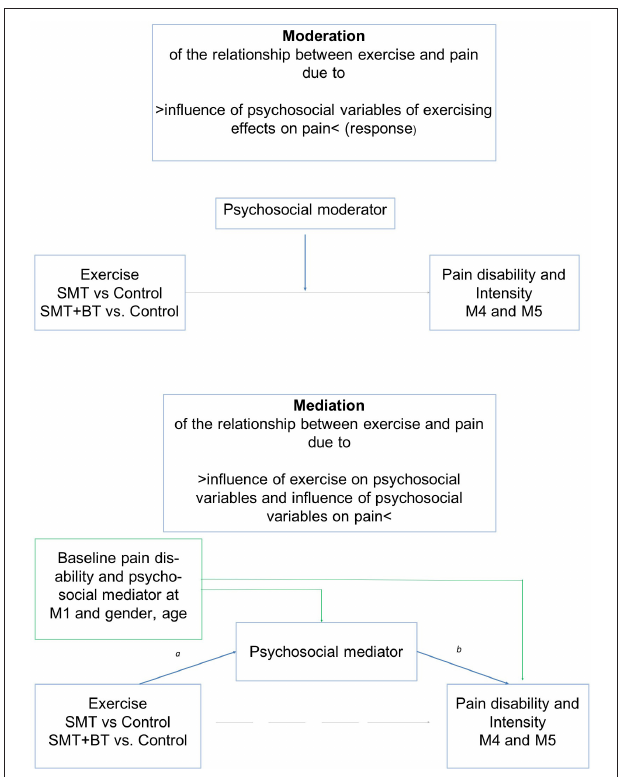
FIGURE 1 | Demonstration of moderation (objective 1) and mediation (objective 2) of psychosocial risk factors on the relationship of exercise and pain. All analyses are controlled for age and sex (mechanisms of interest: blue lines; direct effects: gray lines; possible confounder: green